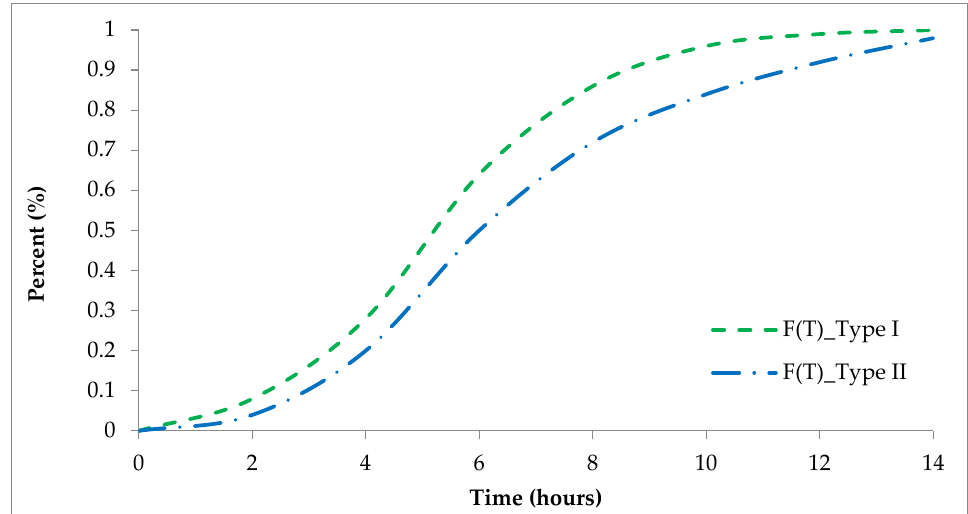
Figure 9. Comparative analysis of the unreliability functions for the analyzed milling teeth. Table 3. Estimation of parameters for the type I milling teeth.